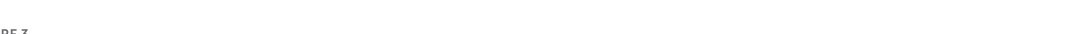
FIGURE3 the generalized performance of ReDisX to identify the DEGs on the RA dataset, GSE93272, which includes the RA patients with/without receiving drug treatments. The explanations for the individual legends are following. (A) PCA and t-SNE visualization of ReDisX labeling of the total number of 13 patients as reassigned by ReDisX in GSE23561 (for text; RA represents the GSE23561 label as RA patient; CAD represents GSE23561 label as CAD patient) (for color; blue indicate the patient cluster as ReDisX cluster 1; red indicate the patient cluster as ReDisX cluster 2). (B) The Venn diagram for the DEGs discovered by the ReDisX label (ReDisX +/–) and drug treatment group label (Drug+/–) (“+” indicate the up-regulated DEGs; “–” indicates the down-regulated DEGs). (C) The stacked bar plot that shows the distribution of different drug treatments within the ReDisX labeled clusters ( x -axis: ReDisX clusters; y -axis: percentage of the patients receiving the different drug treatment). The color-coded legends “drug_treatment” represents the different drug treatment groups as recorded in GSE23561, IFX, MTX, and TCZ indicates the responsiveness for the corresponding drugs; IFX.IR, MTX.IR, and TCZ.IR means irresponsive to the corresponding drugs, and pRA means RA patients without treatments. (D) The heatmap for relative expressions of the up/downregulating DEGs identified in GSE93272 indicated each patient-specific drug group ( p -value < 0.05, log fold change > 0.05, non-overlapping DEGs with other subpopulations). (E) The box plot shows the GZMB expression based on different drug groups ( x -axis and the legend show the different drug treatment groups as recorded in